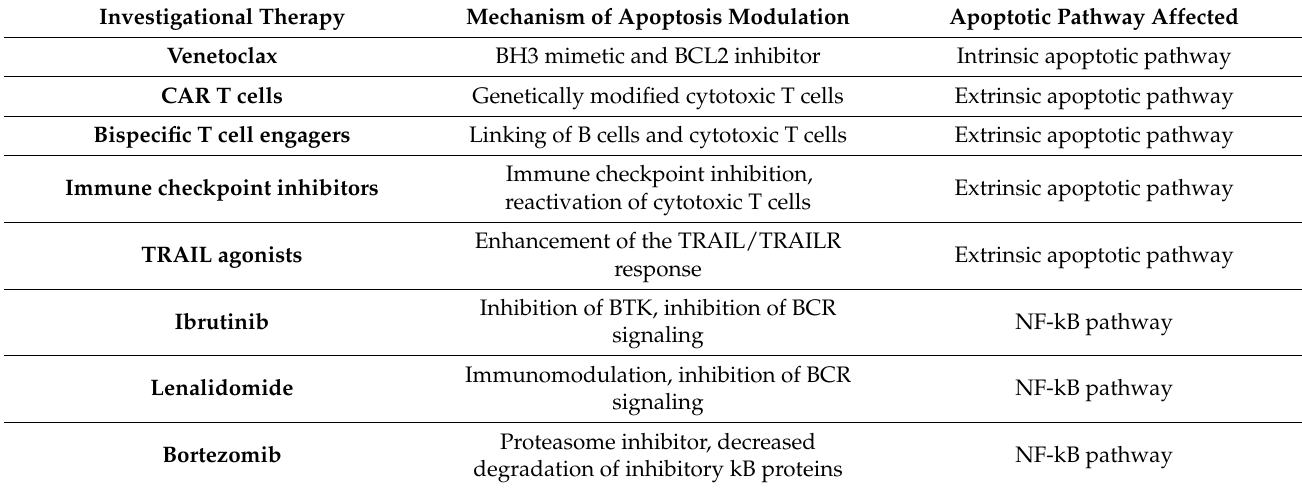
Table 3. Therapies modulating apoptosis being currently investigated clinically in